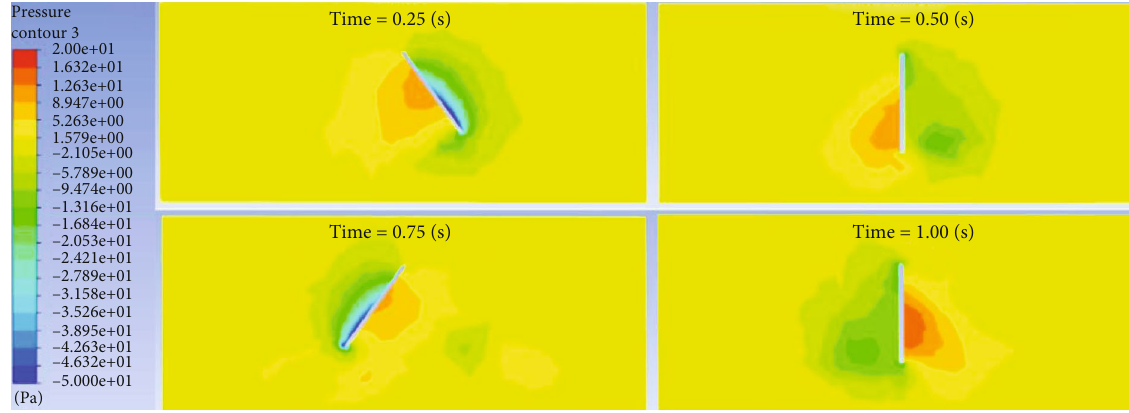
Figure 9: Cross-sectional fl ow fi eld pressure